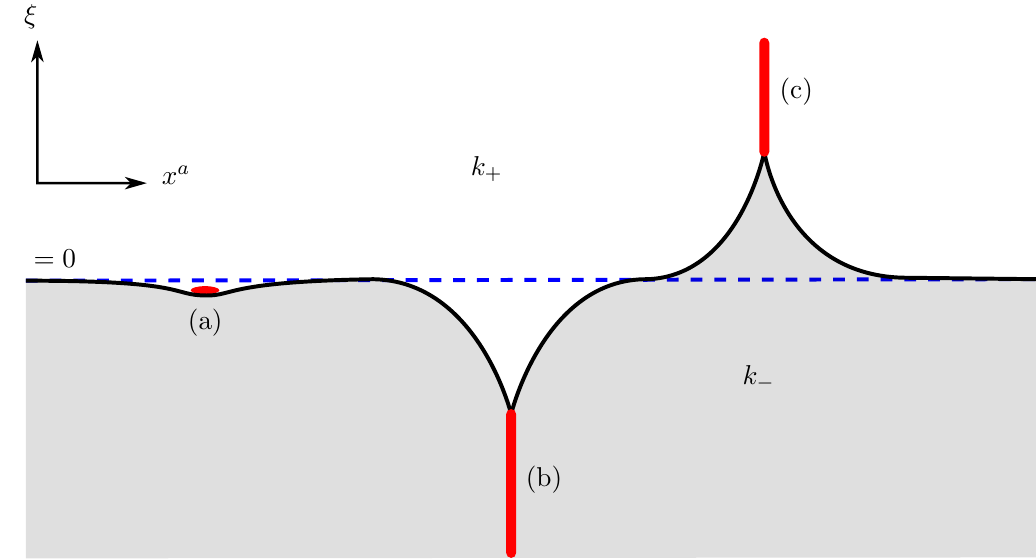
Figure 1 . A schematic representation of the brane, showing the e(cid:11)ect of various forms of stress tensor. The brane is shown in black and the sources are in red. (a) A point mass causes the brane to \sag" i.e., (cid:24) < 0. A gauge transformation to bring the brane back up to (cid:24) = 0 is physically equivalent to adding a negative four dimensional mass to the brane to \(cid:13)oat" it back up. (b) A string pulling on the brane from the inside has the same e(cid:11)ect, while (c) a string pulling from outside has the opposite e(cid:11)ect and contributes with a positive four dimensional energy in a gauge where the brane is